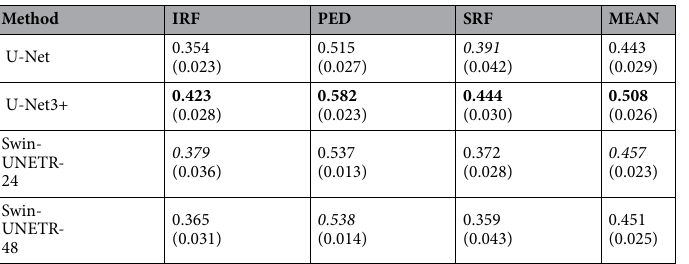
Table 3. Method comparison results. Mean and (standard deviation (std)) of the Dice scores for the four considered methods calculated on the test set over a 5-fold cross-validation (CV). Results reported per class (columns 2-4) and as a weighted average (column 5 (MEAN)). The best performer is displayed in bold, followed by the second best in